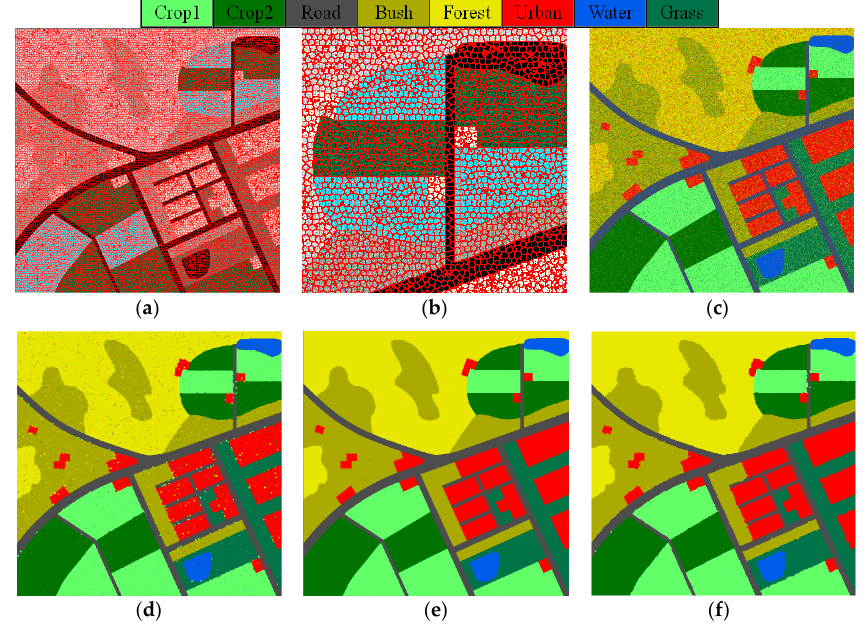
Figure 7. L-band, multi-look PolSAR image of Flevoland of AIRSAR as the third dataset used in the experiment: ( a ) Pauli color-coded image and ( b ) the ground truth map of ( a ). Boxes in ( b ) are the areas of training samples for the AIRSAR data.